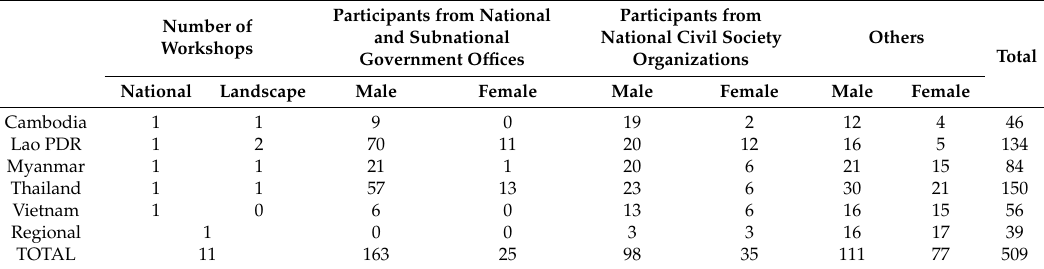
Table A1. Participants in the background research workshops.